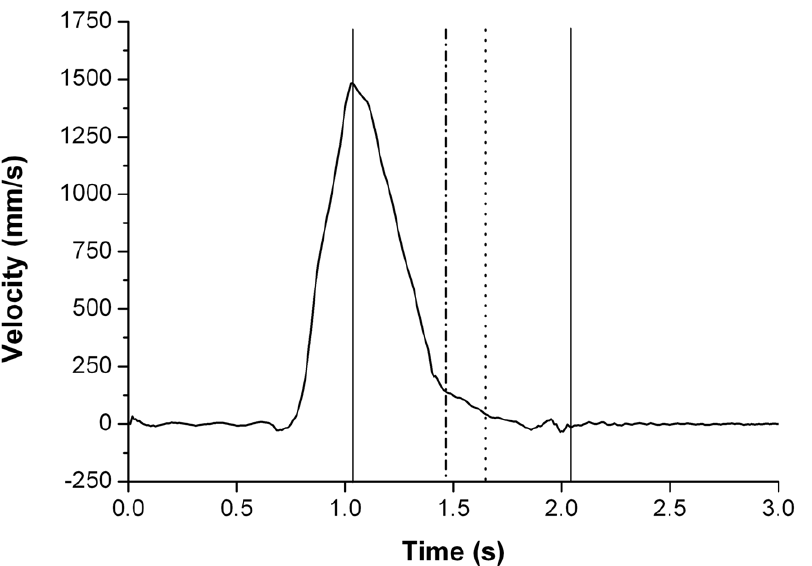
Figure 2. Example velocity profile to show kinematic landmarks. The two vertical solid lines represent the time of peak velocity and the end of the movement. Deceleration time is the time between these two lines. The dot-dash line shows the start of the hover phase (10% of peak velocity). The dotted line represents the end of the hover phase and the start of the final adjustment (FA) phase (3% of peak velocity). It is defined as the finish of the approach to the object. The FA phase ends at the solid line representing the end of the movement.